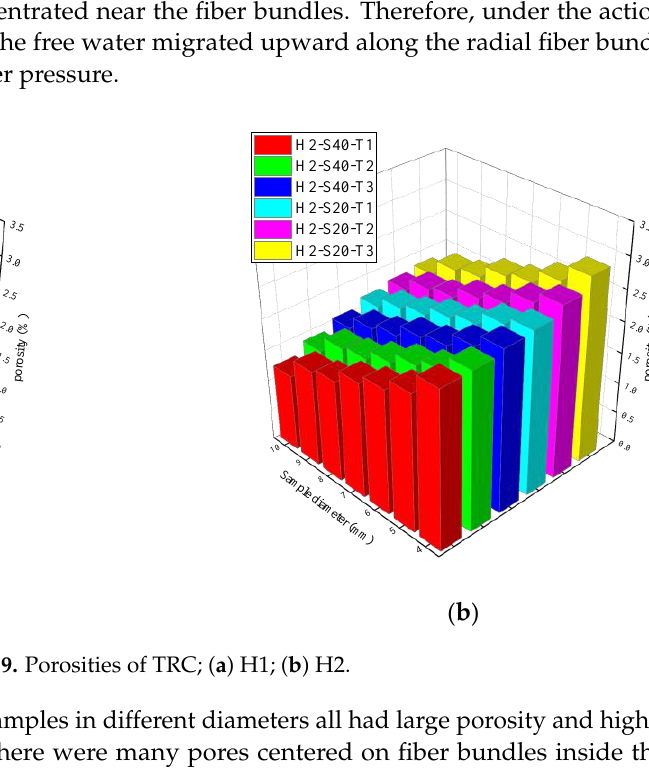
Figure 9. Porosities of TRC; ( a ) H1; ( b ) H2. NMR tests are performed through pulse sequence testing of hydrogenic ionization in water in a porous medium to obtain an attenuation signal. The attenuation amplitude can